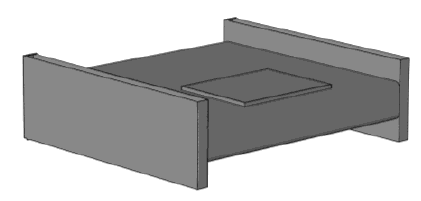
Fig. 1. Model of the hot film sensor.